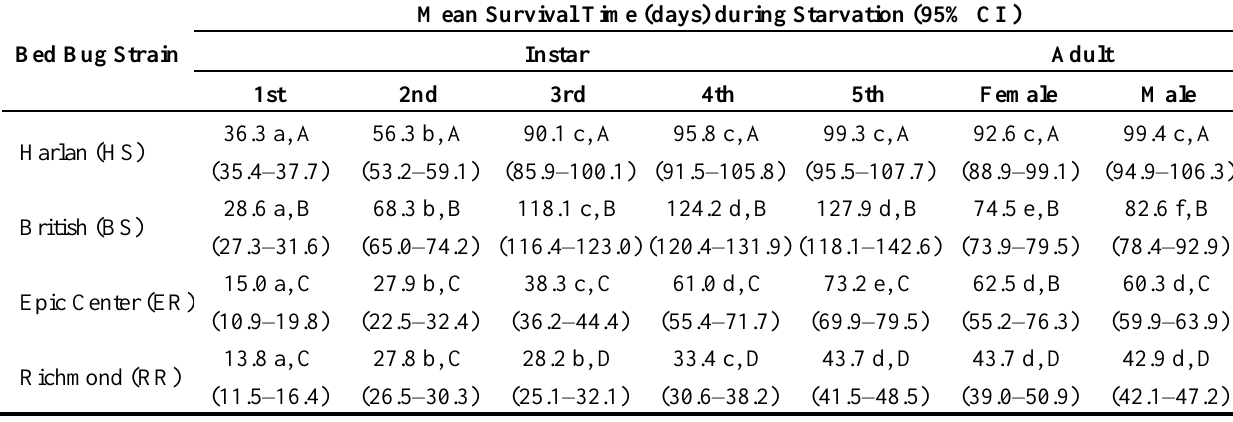
Table 2. Mean (95% CI) survival times (days) during starvation for immature and adult stages of two pyrethroid-susceptible (HS and BS) and two pyrethroid-resistant (RR and ER) bed bug strains (reared at 26.1–26.5 °C, 68.9% RH, photoperiod 12:12 hour